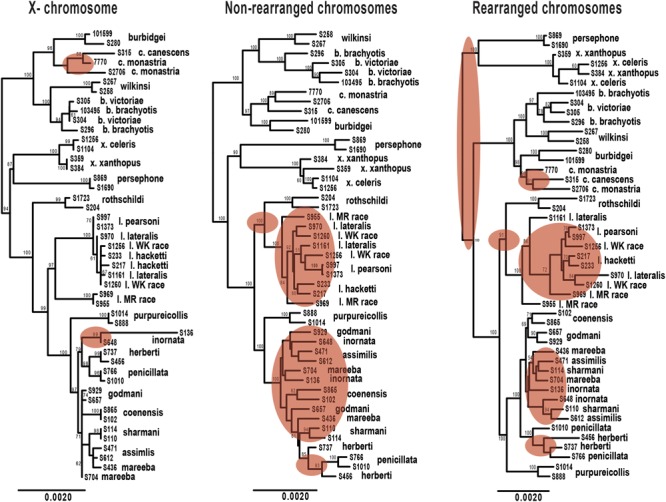
Maximum likelihood phylogenies of Petrogale taxa based on loci from the X chromosome, rearranged autosomal chromosomes (5,6,9,10) and non-rearranged autosomal chromosomes (2,4,7,8). Bootstrap support is highlighted on the nodes of the tree. Incongruence in the phylogenetic reconstruction to the concatenated nuclear phylogeny (Figure 2A) is highlighted in red on each tree.